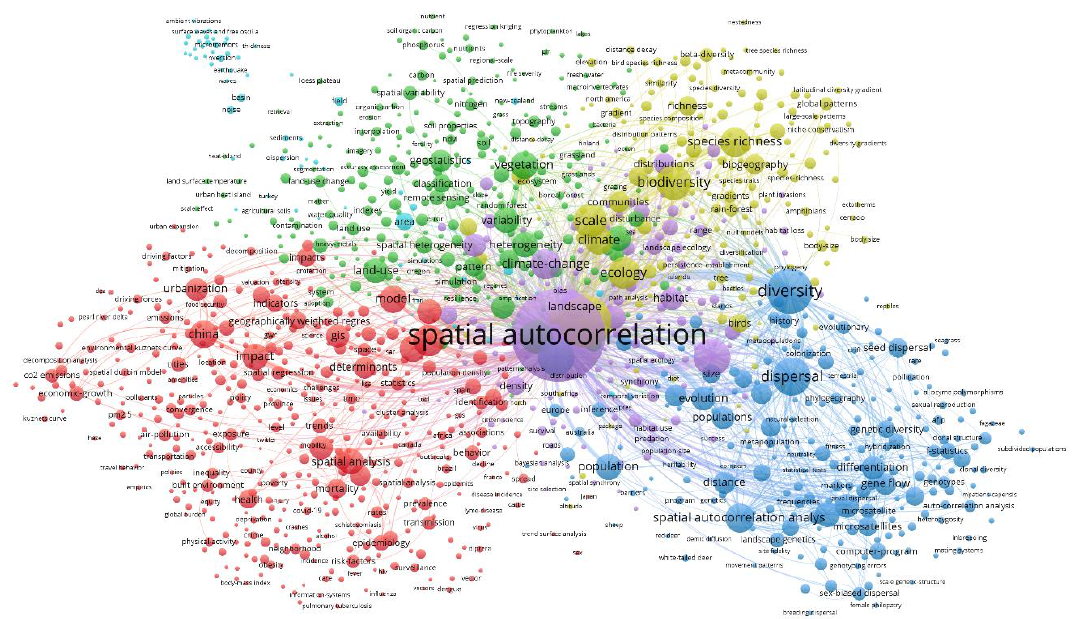
Figure 8. SA keywords co-occurrence map by VOSviewer. (Co-occurrences: spatial autocorrelation, 3227; diversity, 657; dispersal, 461; climate change, 329; China, 329).